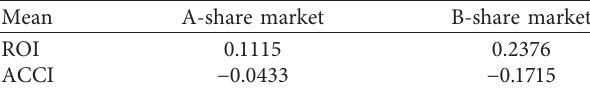
Table 1: Descriptive